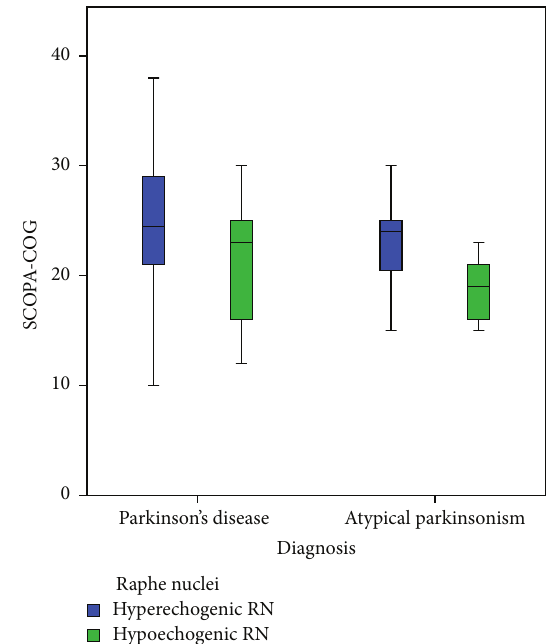
Figure 2: Boxplot of the range of scores on the SCOPA-COG scores compared to the echogenicity of the substantia nigra.